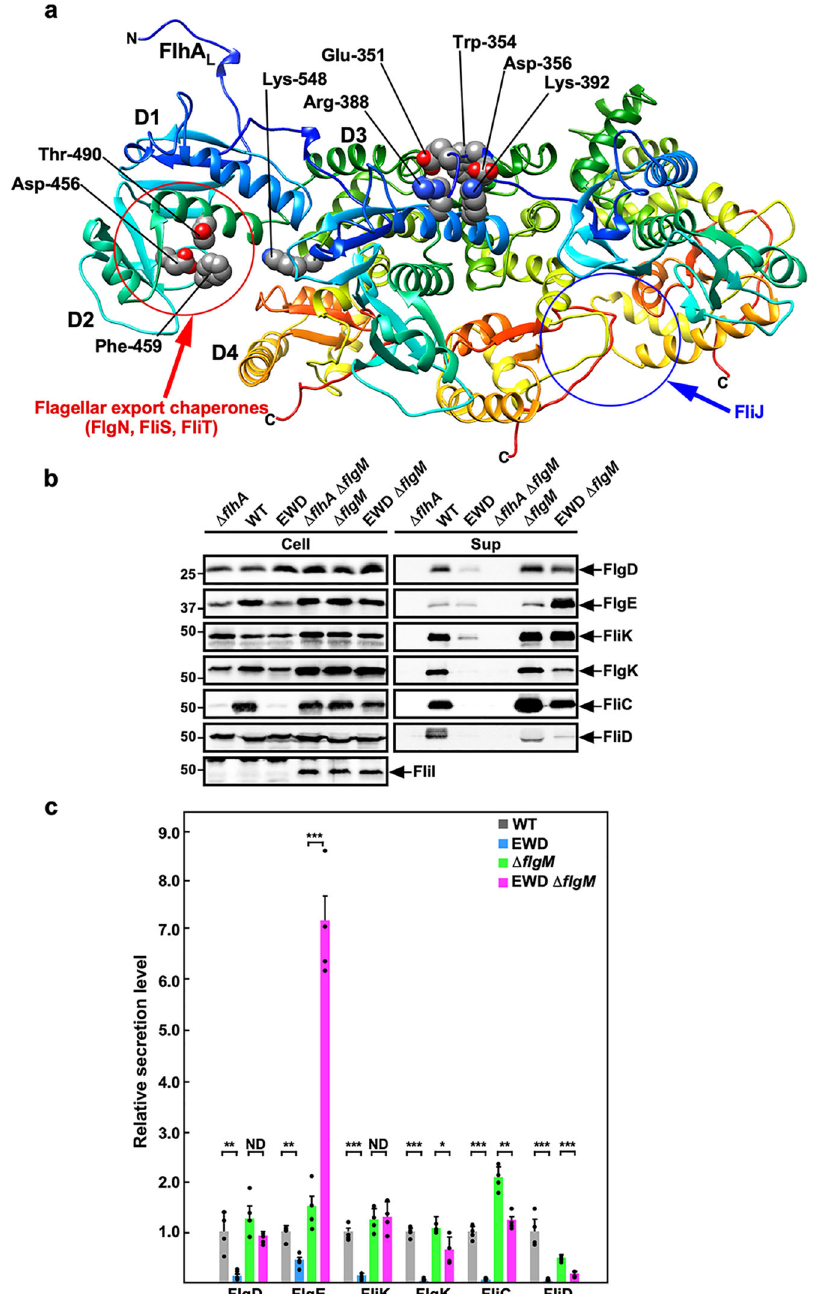
Fig. 2 Effect of the fl hA EWD mutation on fl agellar protein export. a Structural model of the FlhA C ring. Only three FlhA C subunits in the FlhA C nonameric ring model are shown. FlhA C (PDB ID: 3A5I) consists of four domains, D1, D2, D3, and D4 and a fl exible linker (FlhA L ). Glu-351, Trp-354, and Asp-356 of FlhA L binds to the D1 and D3 domains of its neighboring subunit. A well-conserved hydrophobic dimple including Asp-456, Phe-459, and Thr-490 is responsible for the interaction of FlhA C with fl agellar export chaperones in complex with fi lament-type substrates. Phe-459 and Lys-548 are exposed to solvent on the molecular surface when FlhA C adopts the open conformation. FliJ binds not only to FlhA L but also to a large cleft between the D4 domains. b Immunoblotting, using polyclonal anti-FlgD (1st row), anti-FlgE (2nd row), anti-FliK (3rd row), anti-FlgK (4th row), anti-FliC (5th row), anti-FliD (6th row), or anti-FliI (7th row) antibody of whole-cell proteins and culture supernatant fractions prepared from the Salmonella NH001 strain transformed with pTrc99AFF4 ( Δ fl hA ), pMM130 (WT), or pYI003 (EWD) and the NH001gM strain transformed with pTrc99FF4A ( Δ fl hA Δ fl gM ), pMM130 ( Δ fl gM ), or pYI003 (EWD Δ fl gM ). The positions of molecular mass markers are indicated on the left. The regions of interest were cropped from original immunoblots shown in Supplementary Fig. 7. c Relative secretion levels of fl agellar proteins. These data are the average of four independent experiments. The average density of each fl agellar protein seen in the culture supernatant derived from wild-type cells was set to 1.0, and then relative band density was calculated. Vertical bars indicate standard deviations. Dots indicate individual data points. The source data are shown in Supplementary Data File. Comparisons between datasets were performed using a two-tailed Student ’ s t -test. A P value of <0.05 was considered to be statistically signi fi cant difference. * P < 0.05; * P < 0.01; ** P < 0.001; ND no statistical